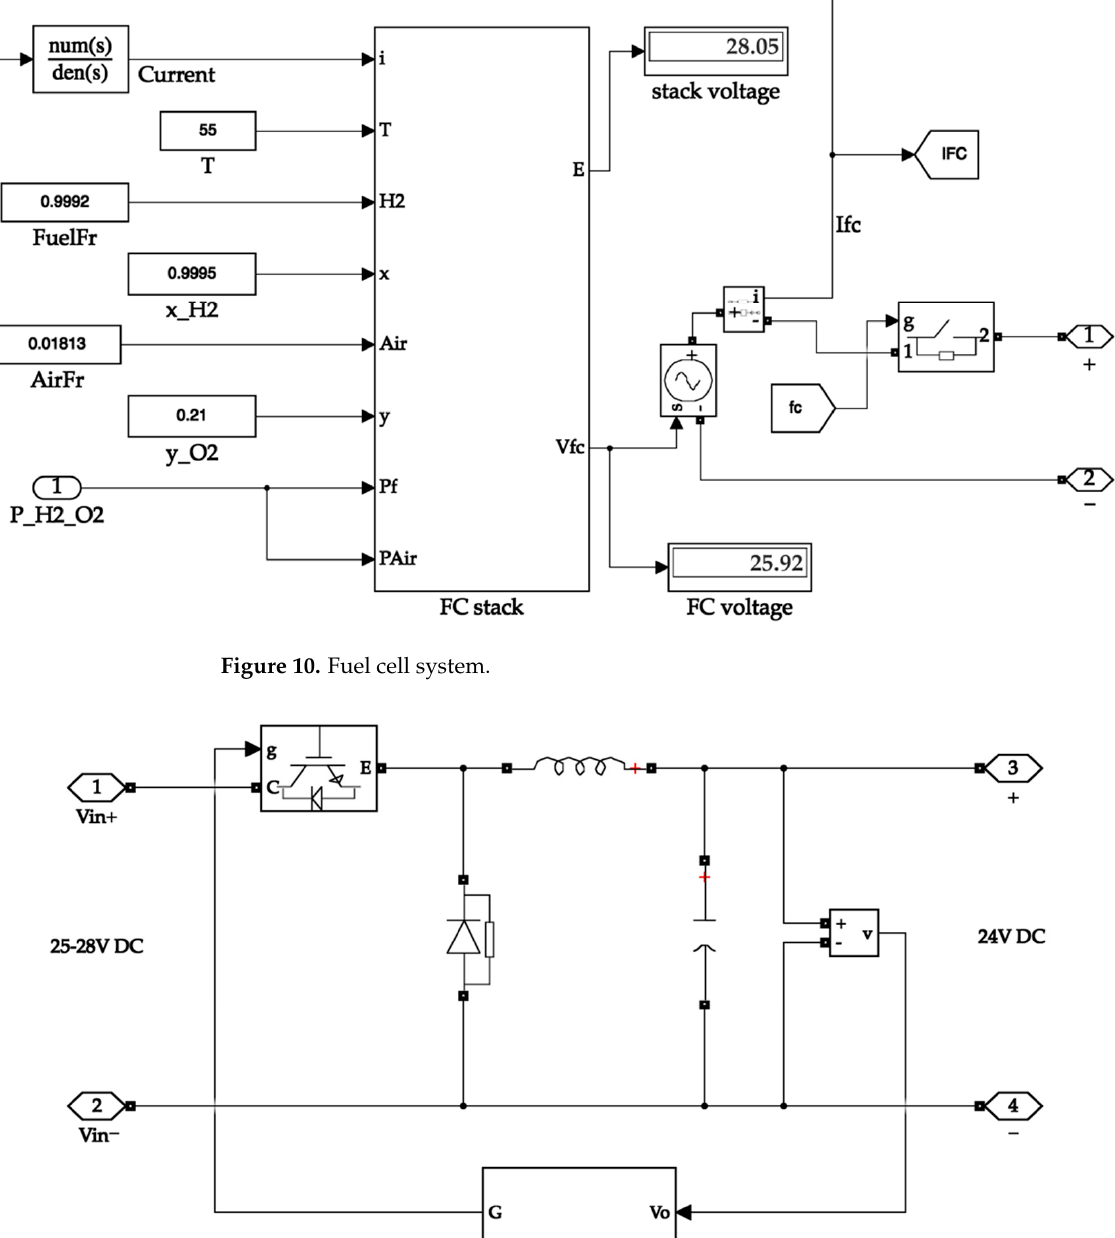
Figure 9. Hydrogen storage tank.